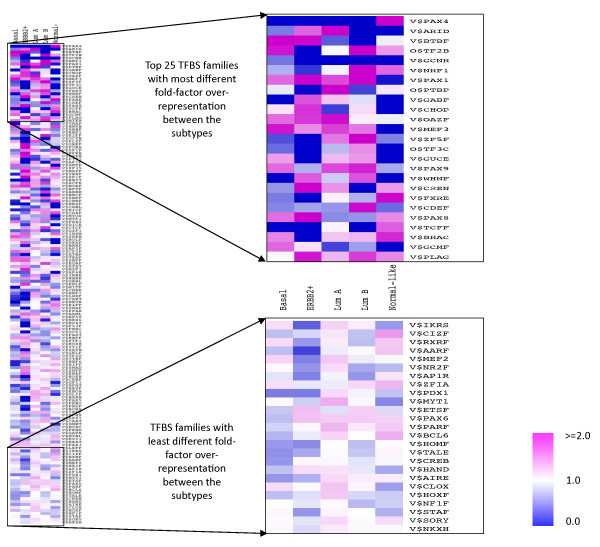
Heatmap of fold overrepresentations for the TFBS families ranked according to their distance from center. Out of all, 25 TFBS matrix families top ranked according to their distance from the centroid of fold-overrepresentation matrix, are highlighted